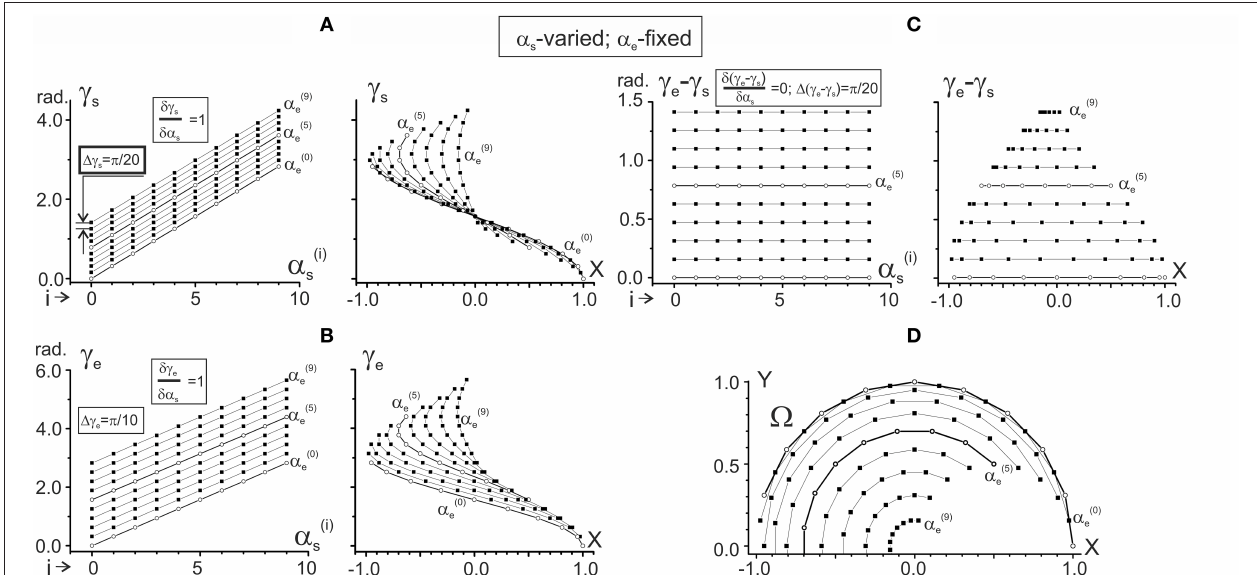
FIGURE 2 | Changes in the characteristic angles γ s and γ e and their difference in dependence on α s provided that α e is fixed. Steps of changes in both arguments are chosen as π /10rad; separate dependences from α s are drawn for 10 fixed values of α e , ranging from α (0) e = 0 to α (9) e = 9 π /10rad. Successive procedures of numerical analysis are presented in Table 1 , left column. The right columns in (A–C) present the same data as in the left ones after changing the end-point angles by their projections on the X-axis of the working space (cid:127) (shown in D ). For better distinguishing, the traces α (0) e and α (5) e are marked by open circles. For purposes of the data treatment, additional quantitative information about slopes of the characteristics and distances between them is placed in squares at the correspondent panels. Note the same ordinate calibrations in the paired plots of (A–C) and the conformity between the points in these plots and their positioning within the working space (cid:127) (D) . All dimension characteristics in this and other figures are normalized with respect to the radius of the working space ( R = 2L = 1).